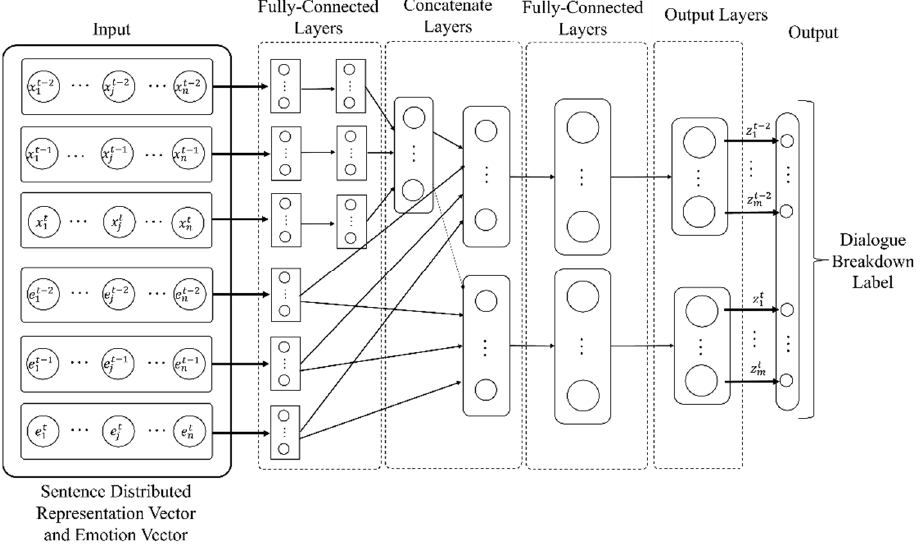
Figure 5. Multi-task learning of dialogue breakdown label.